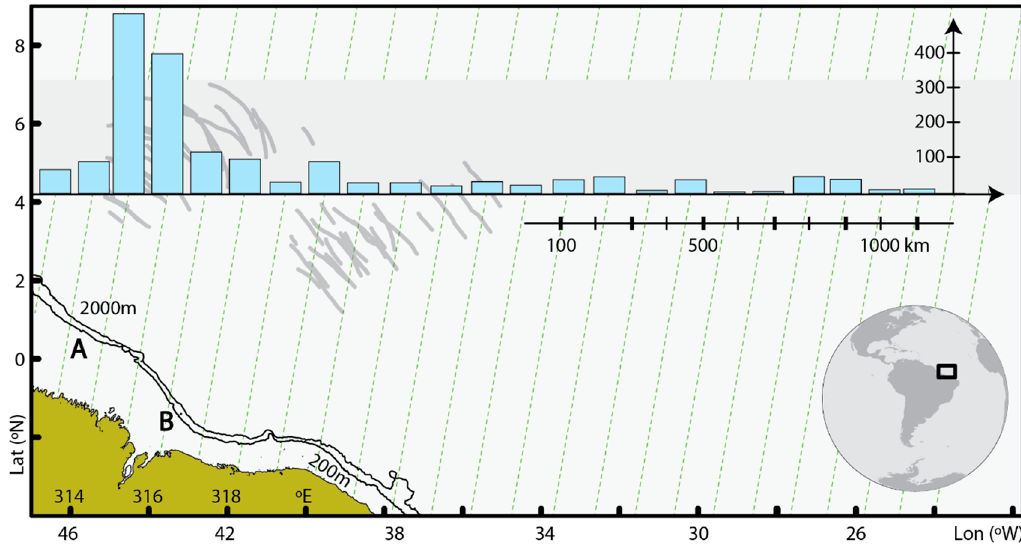
Figure 11. Map of the tropical Atlantic Ocean off the Amazon shelf showing the number of occurrences of cell detections by the algorithm in this paper. The green dotted lines represent the Sentinel-3A satellite tracks analyzed in this study (a total of 25 tracks). In grey shade are represented the ISW crests previously reported in Reference [9]. The grey background band represents the region analyzed with the SRAL data, which spans from approximately 25 ° W to 46 ° W (more than 2000 km along the equator). The vertical axis on the right hand side of the bar plot represents the number of total cells detected for each track. The 200 m and 2000 m isobaths are drawn in black, labels A and B represent the likely origin of the ISWs, and the South American continent is hatched in green.